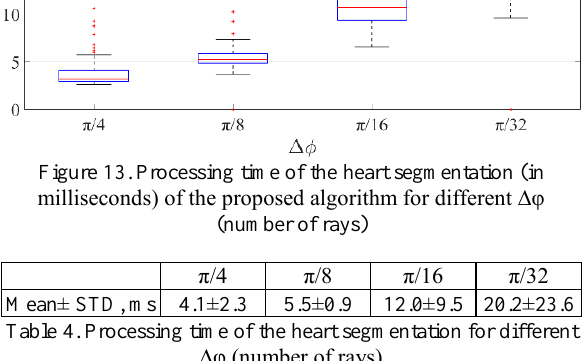
Table 4. Processing time of the heart segmentation for different